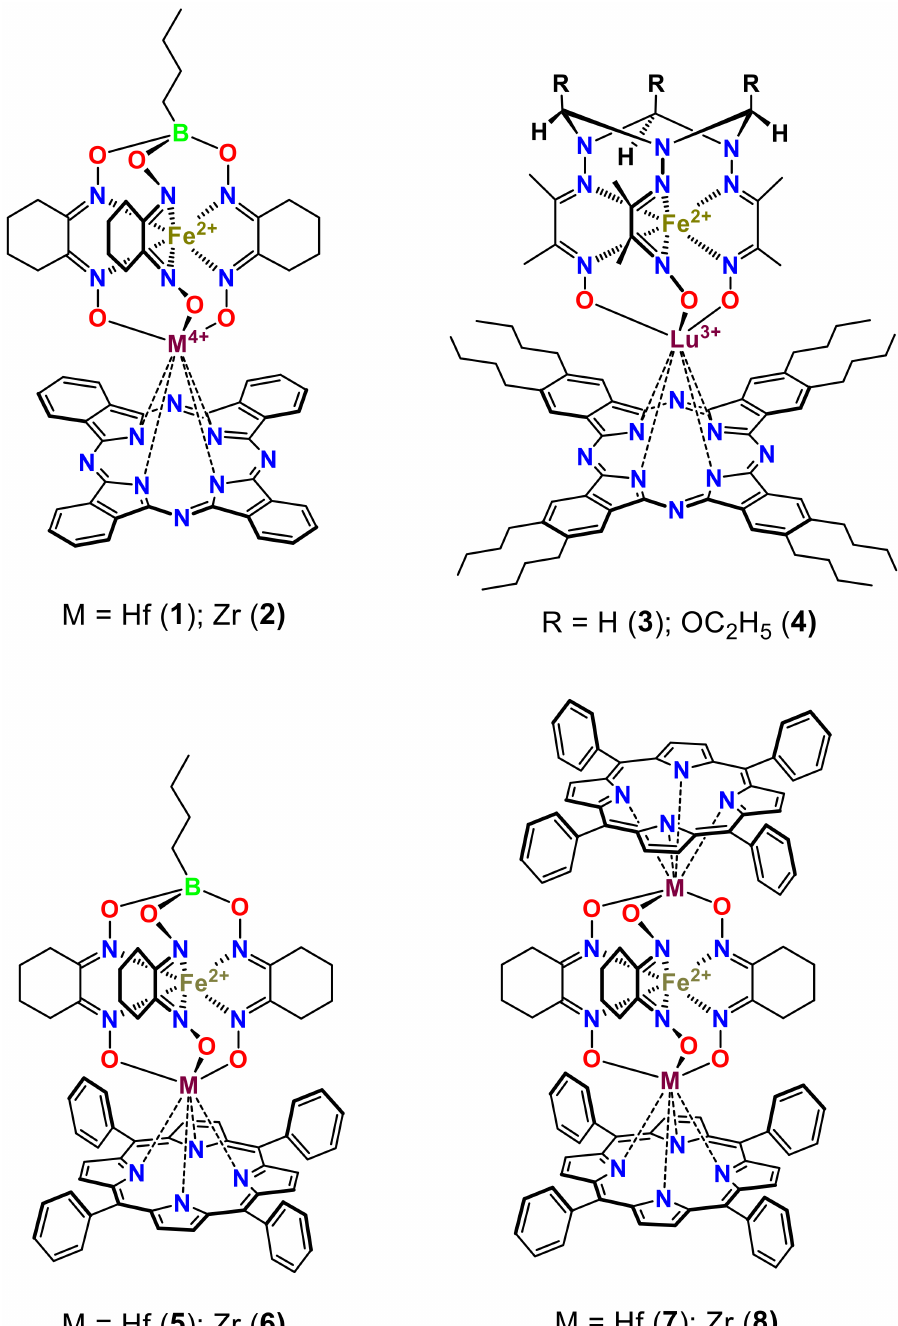
The phthalocyanine π -systems are known to possess photo- and electrochromic prop- erties, as well as photocatalytic activity [43–45]. The phthalocyanine-based catalysts [46] can be easily obtained and possess very high chemical robustness even in harsh media. On the other hand, the designed d -metal clathrochelates were reported [47–49] to be useful for protein sensing or efficient electro- and (pre)catalysts for hydrogen and syngas (H 2 + CO) production. A series of the polyamine cobalt(III) cage complexes with tethered mercap- toethylamide terminated oligopeptide apical substituents, allowing for immobilization on a surface of the working gold electrode, was described [50] to be potent heterogeneous elec- trocatalysts in both the hydrogen evaluation reaction (HER) and the oxygen reduction to hydrogen peroxide. Photodissociation of water was realized on rhodium-doped